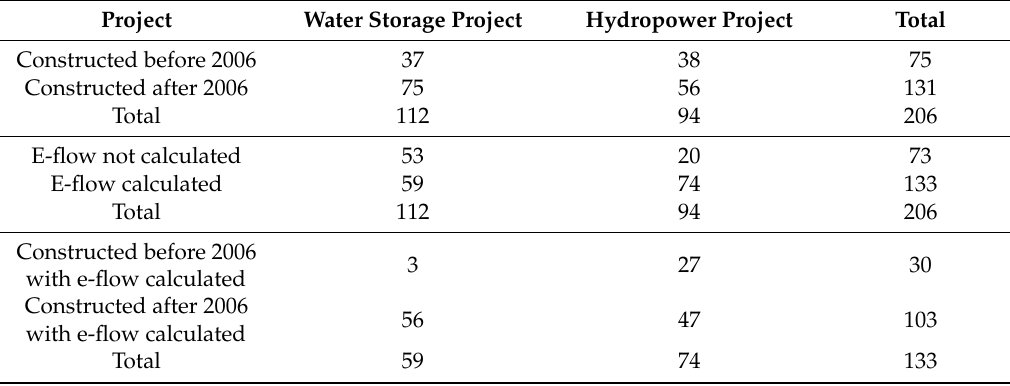
Table 1. Characteristic parameters of the water storage and hydropower